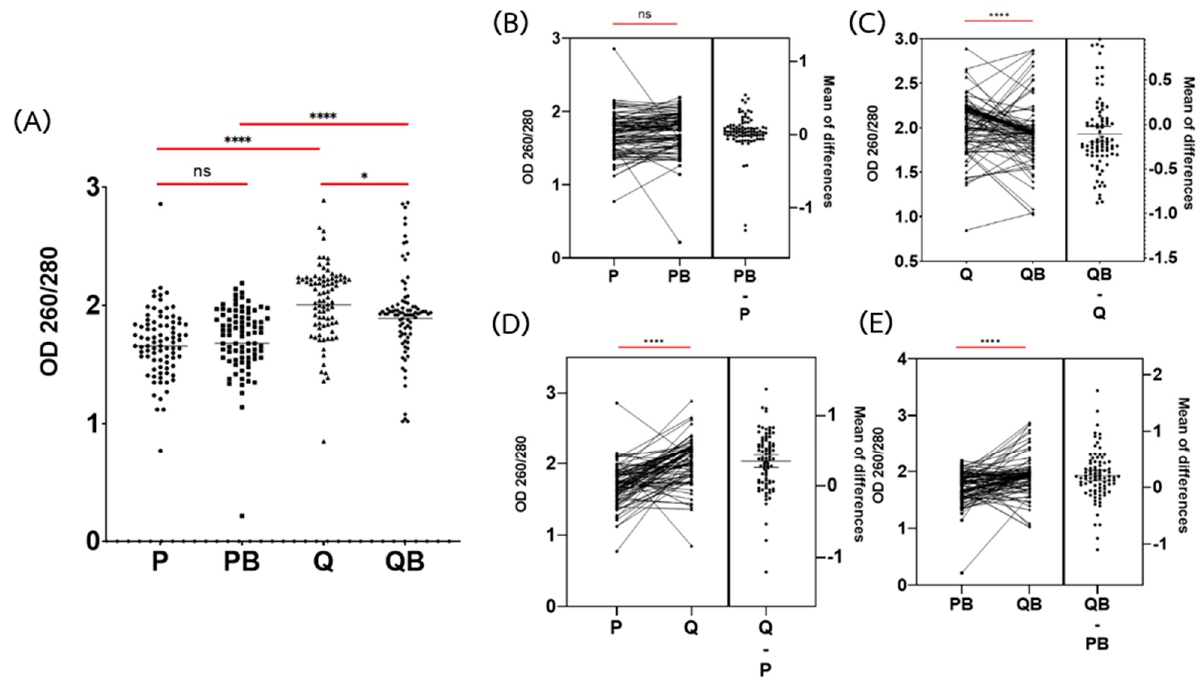
Figure 2. Comparison of the OD260/280 absorbance ratios of the genomic DNA extracted via the phenol-chloroform extraction method (P), the phenol-chloroform extraction method with glass beads (PB), the QIAamp Fast DNA Stool Mini Kit (Q), and the QIAamp Power Fecal Pro DNA Kit (QB). ( A ) Dot plot of DNA concentrations via extraction methods. Each dot indicated the DNA concentrations of each sample. ( B – E ) Estimation plot of the DNA concentrations among the extraction methods. Each line in the left panel indicated a comparison of the DNA concentration of each sample extracted by each method. Each dot in the right-hand panel indicated the differences between the DNA concentrations of each sample. The bar indicated the mean of the differences between concentrations. **** Statistical differences using a paired t -test ( p < 0.0001), * Statistical differences using a paired t -test ( p < 0.05), ns: non-significant differences ( p > 0.05).